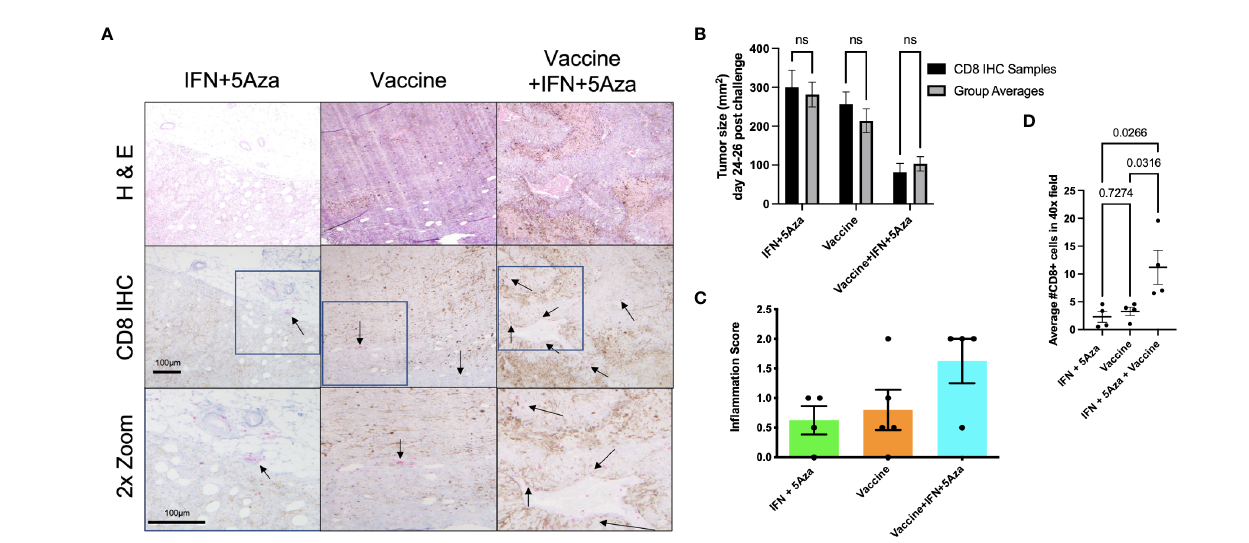
FIGURE 6 CD8 Immunohistochemistry (IHC). (A) IHC of tumor sections. CD8+ cells were stained with pink color to differentiate from brown melanin background. Representative images were selected and scored by group-blinded dermatopathologist from slides stained from 4 samples per group across two independent experiments. Top two rows utilized 10x objective. Bottom row images were digitally zoomed 2x from boxes in middle row. Arrows are pointing to select clusters of CD8+ cells. (B) Tumor size comparison of CD8 IHC samples to group averages across experiments, tested by 2-way Anova with Sidak multiple comparison test; n.s. = not signi fi cant. (C) Semi-quantitative tumor in fl ammation scores. (D) Average of CD8+ cell counts from twenty random and blinded fi elds per sample from parenchymal regions using a 40x objective, tested by One-way Anova with Tukey ’ s multiple comparison